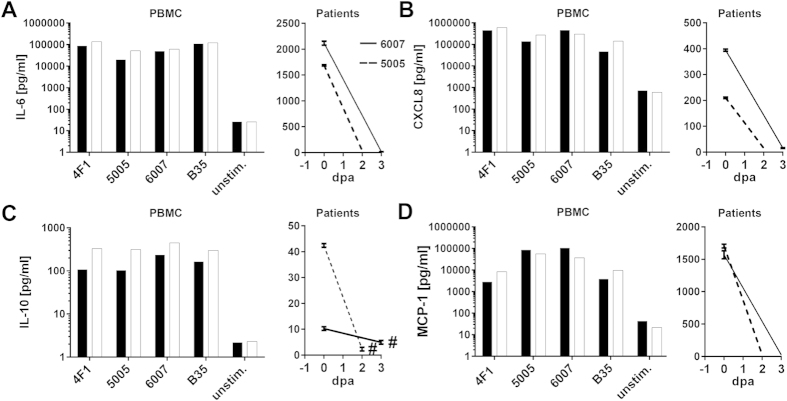
Cytokine release by human immune cells in response to SDSE supernatant stimulations.(A) IL-6, CXCL8 (B), IL-10 (C), and MCP-1 (D) release by PBMCs from two healthy donors after stimulation with supernatants from indicated strains (left panel) and in patient plasma samples (right panel). #, under detection limit. Mean values ± SD from two technical replica of each patient are shown (right panel).